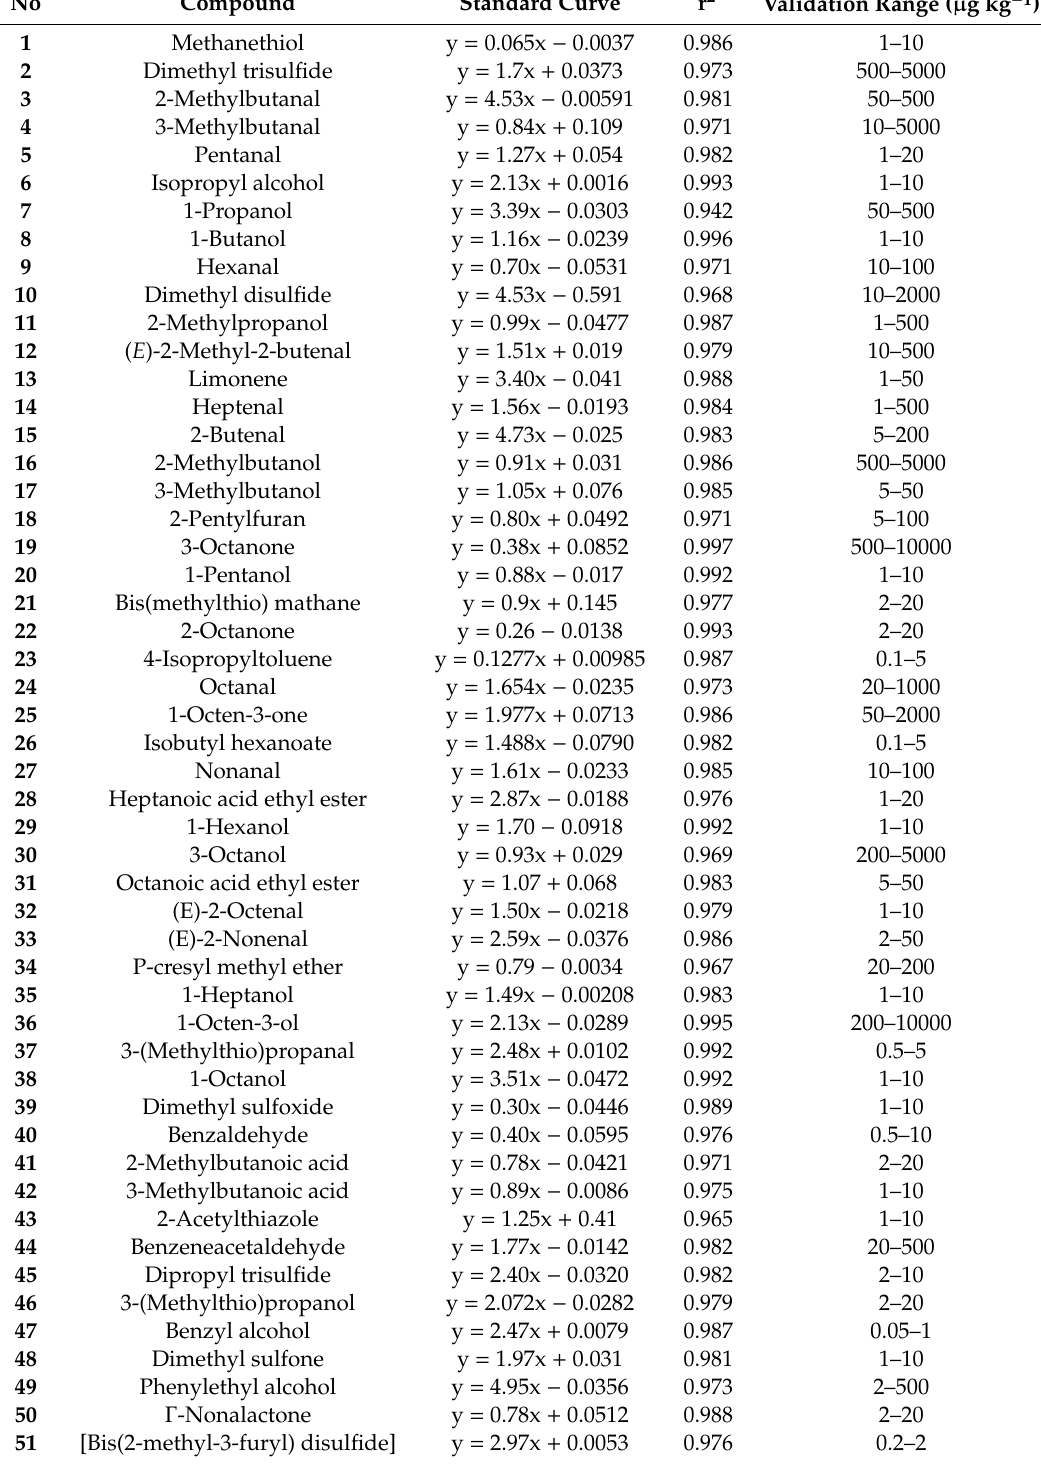
Table 3. Standard curves, validation range and correlation coe ffi cients of standards (r 2 ) for the volatile compounds in tru ffl e